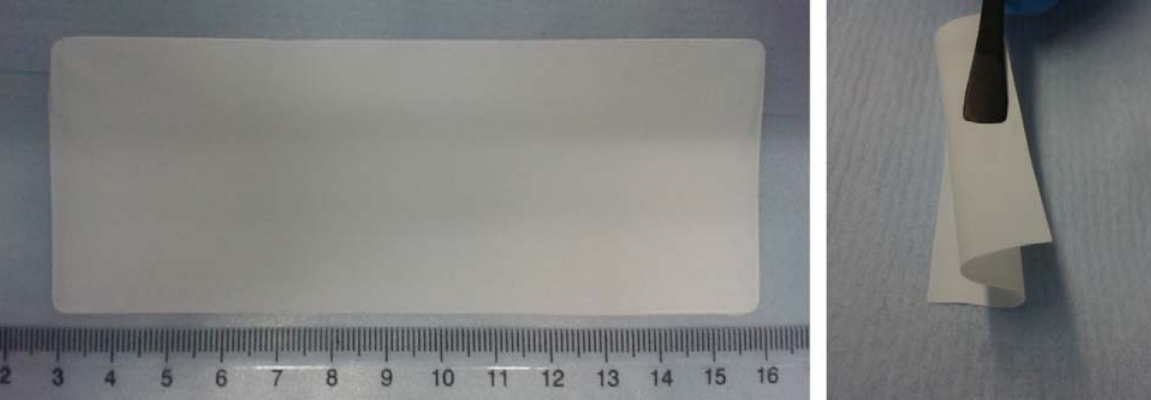
Figure 1. Images of the self-standing SiO 2 –HPG membrane after drying and removal from the PTFE tape. The good flexibility and self-integrity of the membrane is well evidenced in the right